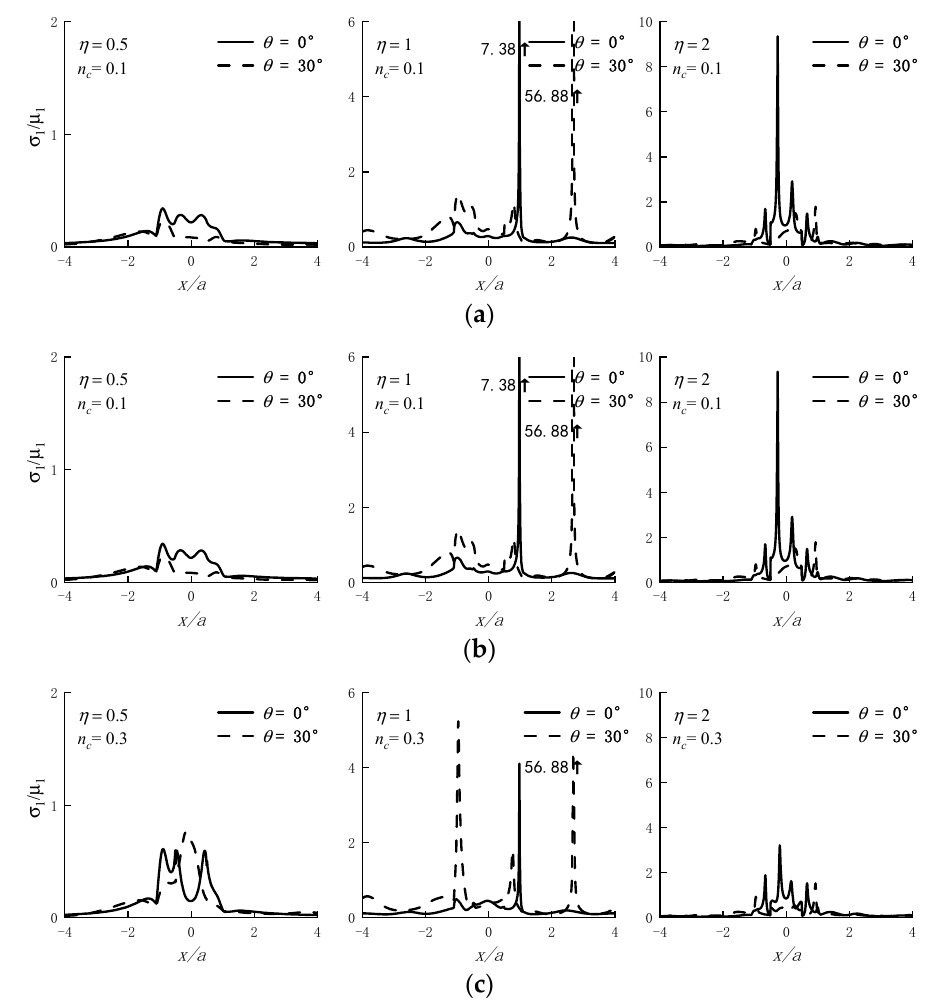
Figure 9. Coefficient of variation in horizontal direction. ( a ) n c = 0.1; ( b ) n c = 0.2; ( c ) n c = 0.3 .